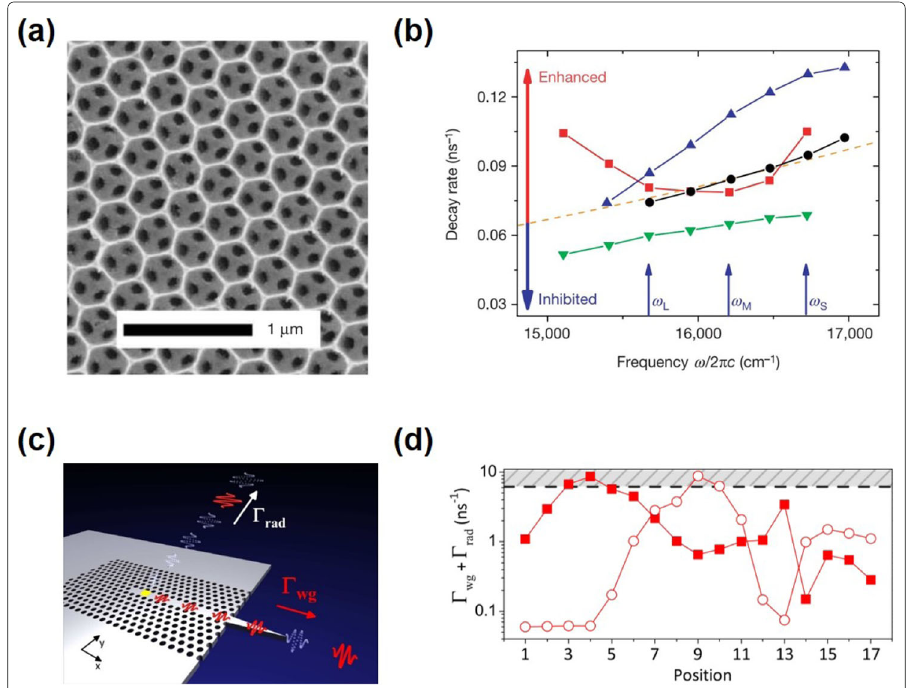
Fig. 5 Spontaneous emission enhancement in PC structures. a The SEM structure image of the inverse opal 3D PCs [162]. b Measured decay rates of the excited states in the inverse opal 3D PCs with different lattice parameters [162]. c Illustration of a single photon source based on a one-way PC waveguide [163]. d Effective decay rate with different positions in the structure ( c )